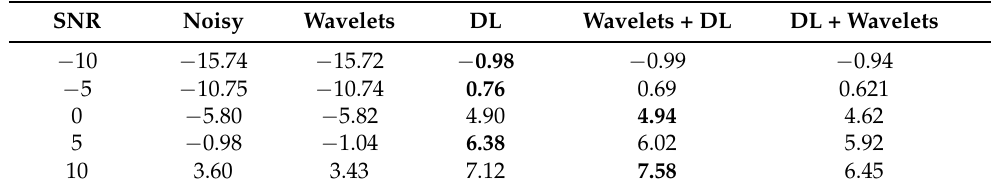
Table 2. Babble noise SegSNR. The higher values represent better results. In bold is the best result for each SNR level.